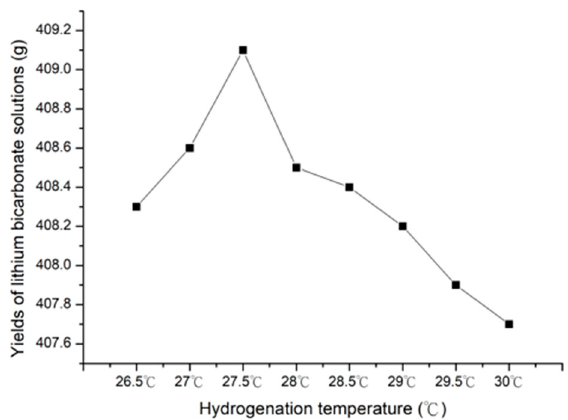
Figure 3. The yields of lithium bicarbonate solutions with different hydrogenation